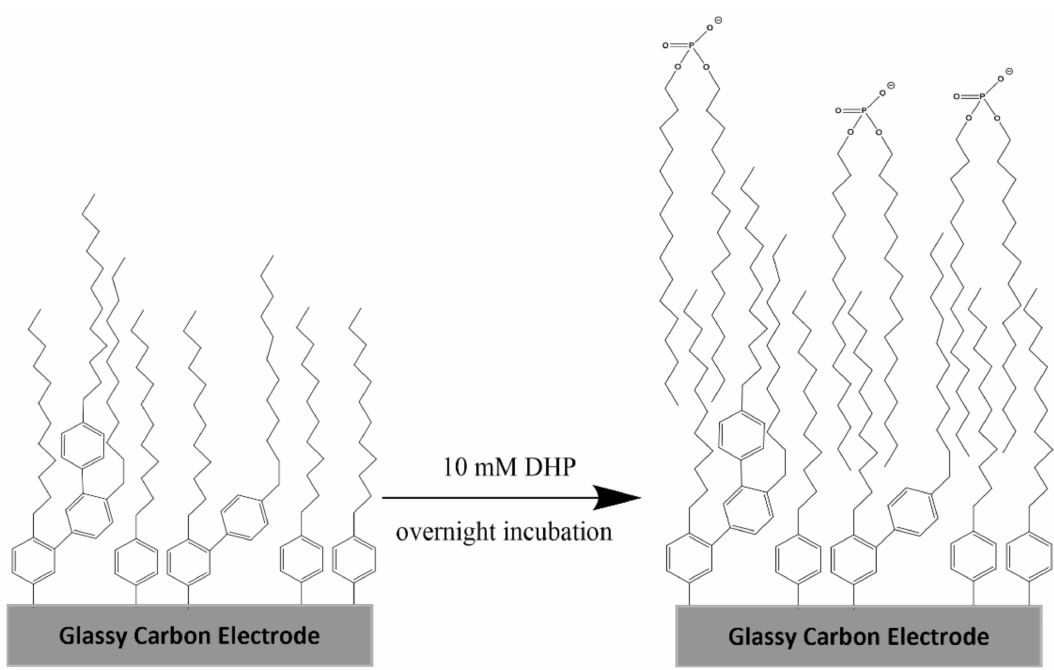
Scheme 2. Schematic illustration of the immobilization of DHP to form the bilayer by the incubation of DHP vesicles on the GCE surface